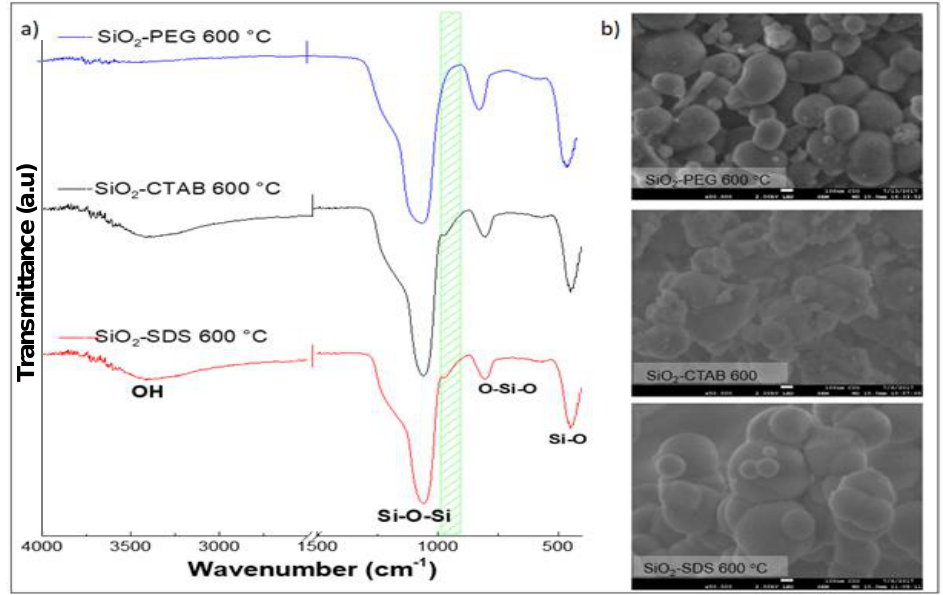
Figure 2. ( a ) FTIR-ATR spectra and ( b ) micrographs at 50,000 X of SiO 2 -PEG, SiO 2 -CTAB, and SiO 2 -SDS samples, heat-treated at 600 °C with a heating rate of 1 °C/min.